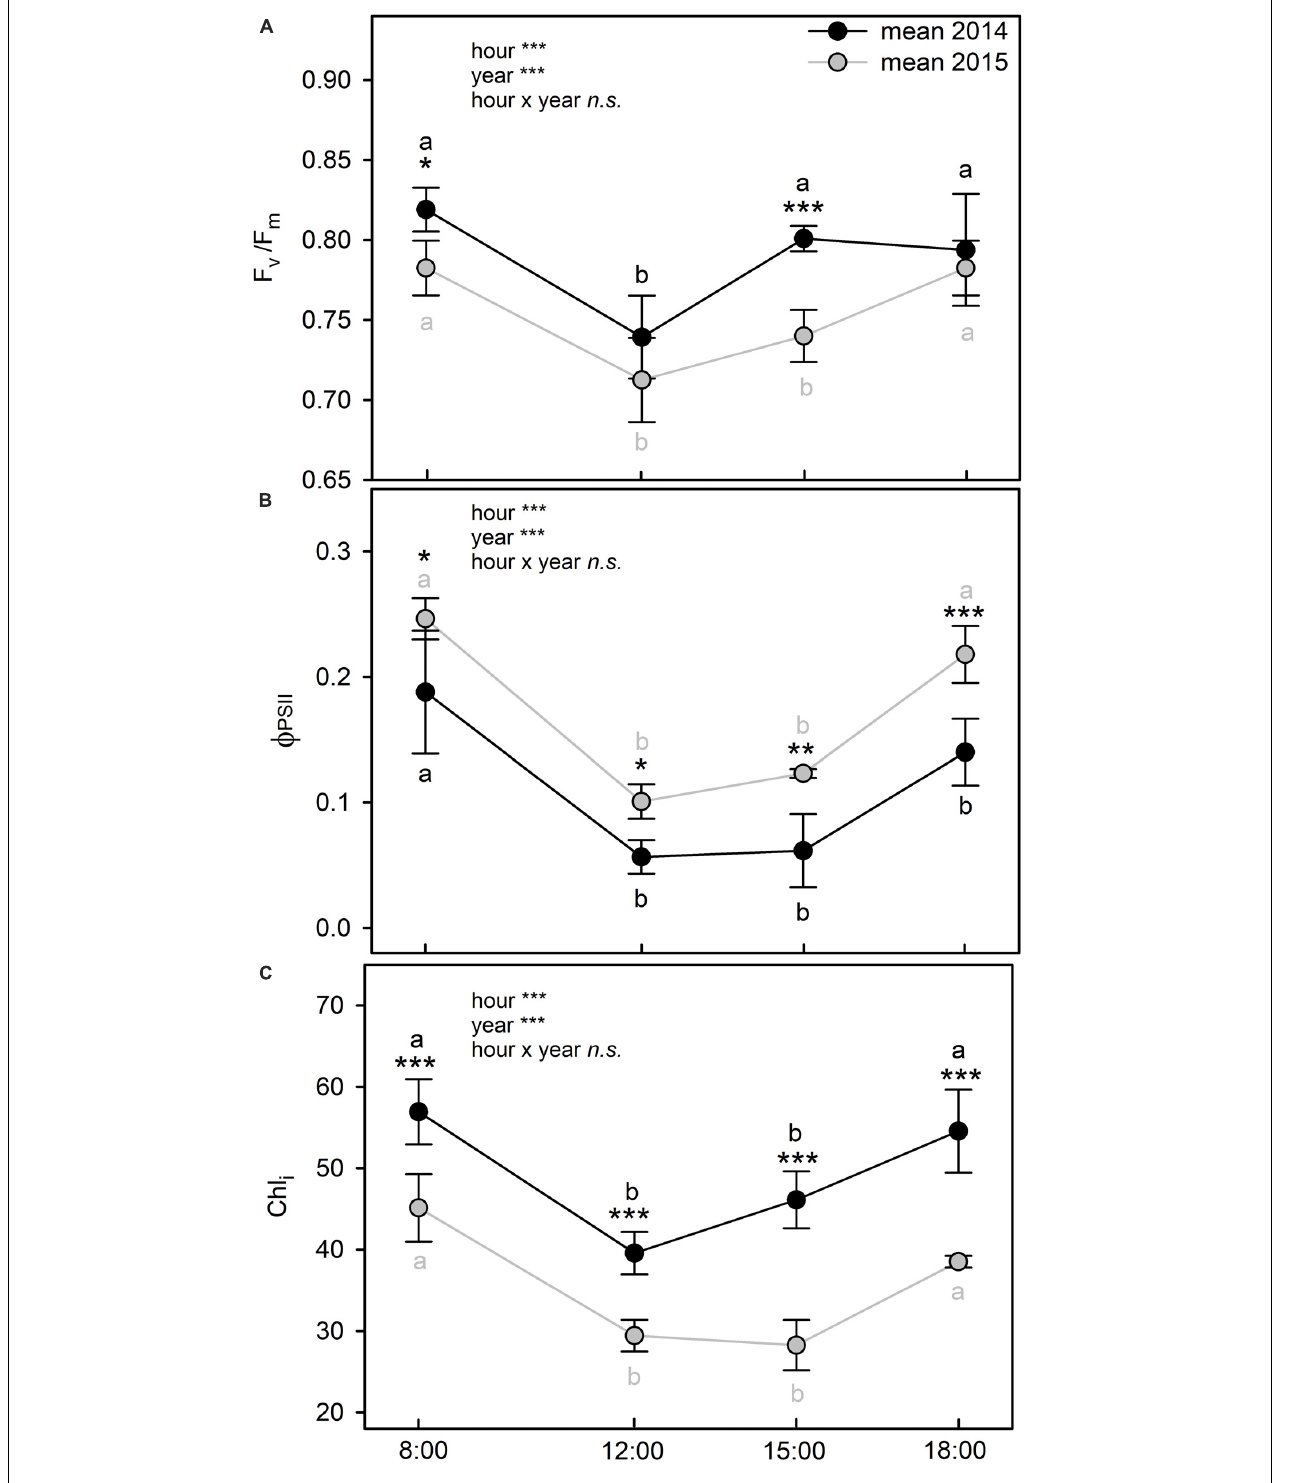
FIGURE 5 | Diurnal trends of maximal photochemical efficiency of PSII (F v /F m ) (A) , actual efficiency of PSII ( (cid:56) PSII ) (B) , and Chlorophyll index (Chl i ) (C) of C . incanus leaves in July 2014 and 2015. Two way ANOVA followed by Tukey’s pairwise comparison was performed to compare data (means ± SD; n = 8). Letters indicate significant differences ( p ≤ 0.05) among sampling hour for each year, whereas asterisks represent significant differences among years for each sampling hour, *( p ≤ 0.05), **( p ≤ 0.01), ***( p ≤ 0.001).